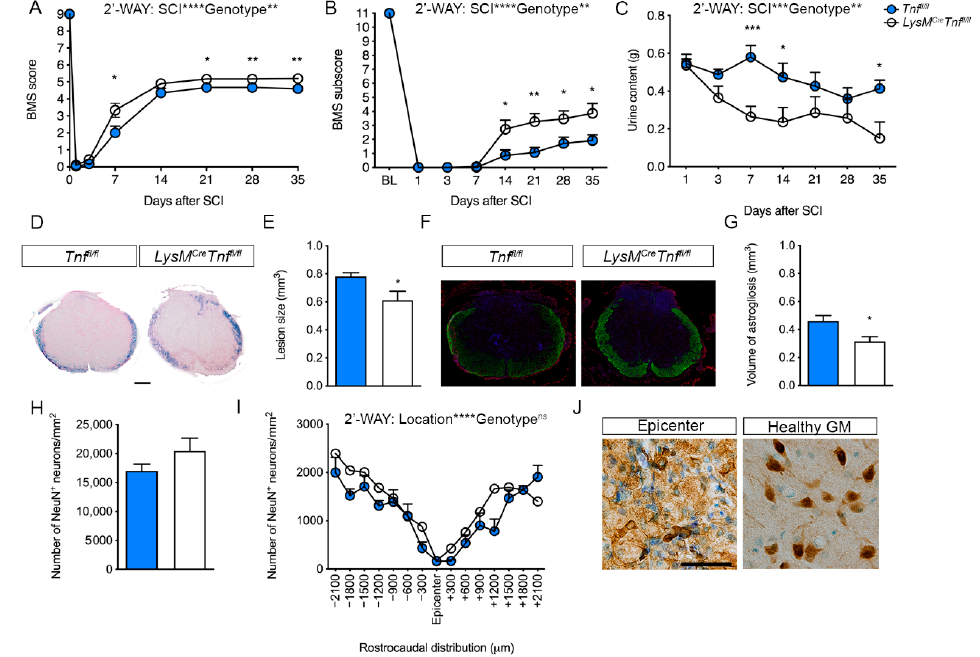
Figure 1. Conditional ablation of myeloid tumor necrosis factor (TNF) improves motor functions and decreases lesion volume after spinal cord injury (SCI). ( A ) Analysis of Basso Mouse Scale (BMS) scores in Tnf fl/fl and LysM Cre Tnf fl/fl mice showed that conditional ablation of myeloid TNF significantly improved BMS scores after SCI. Both groups of mice improved their BMS score over time (two-way RM ANOVA, SCI: p < 0.0001, F 2.1,57.4 = 606.4; Genotype: p < 0.01, F 1,27 = 8.6; Interaction: p < 0.01, F 7,189 =